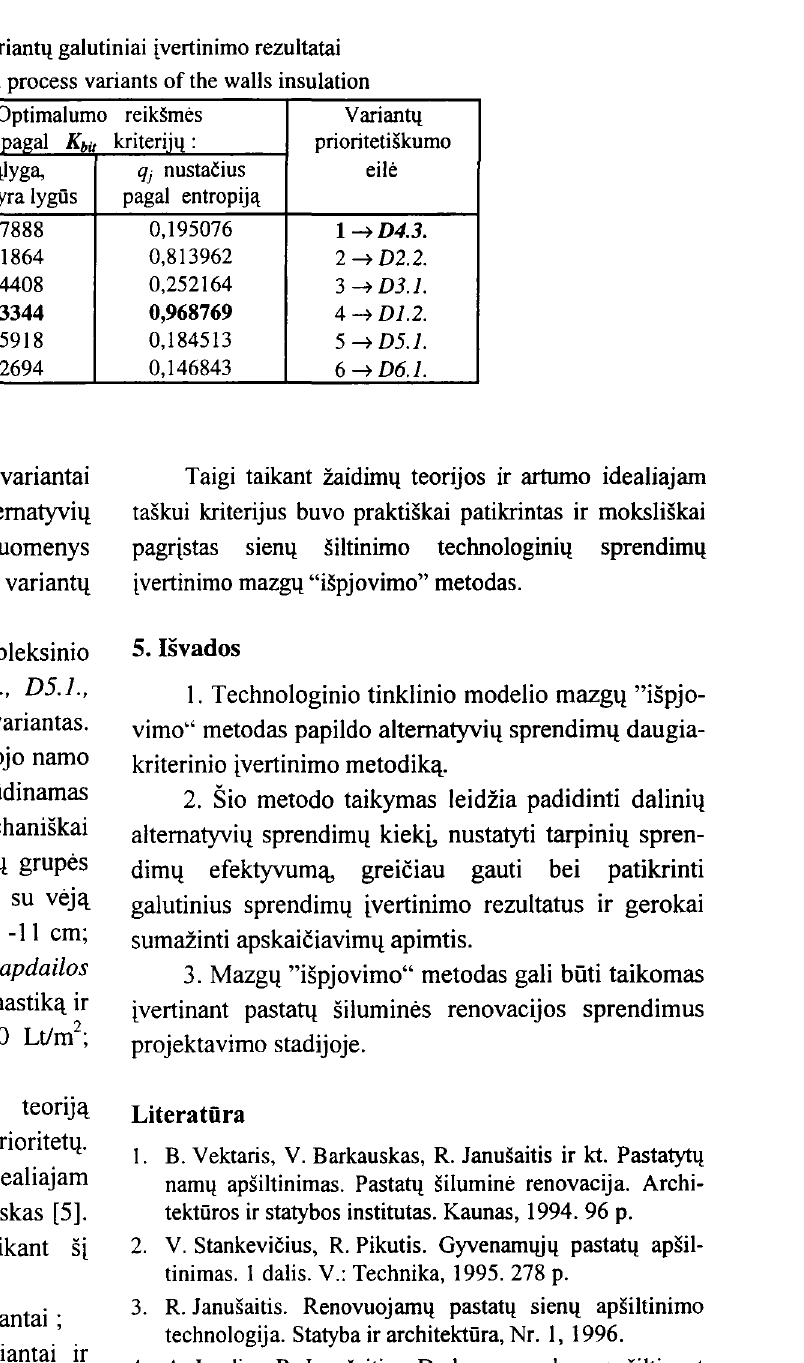
Table 9. The final estimated results of the complex process variants of the walls insulation Sienq